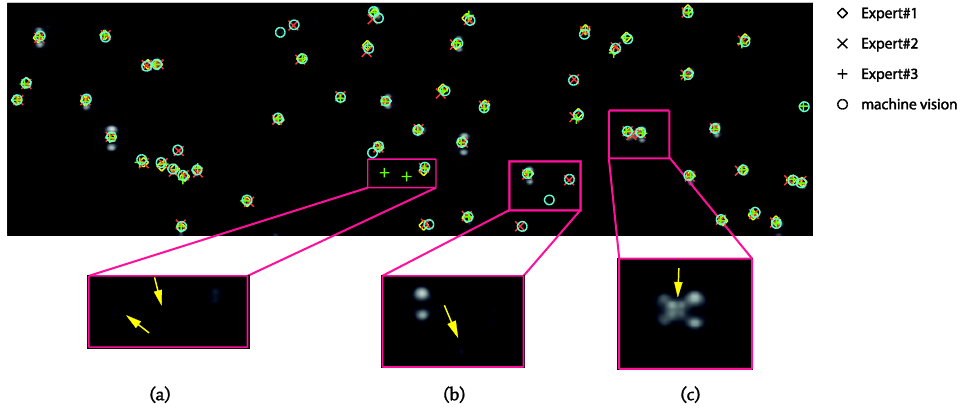
Figure 13. Discrepancies between human-eye and machine vision (MV) output. ( a ) Isolated bubble, rejected by MV but accepted by human-eye ( b ) Isolated bubble, accepted by MV but rejected by human-eye ( c ) merging bubbles.